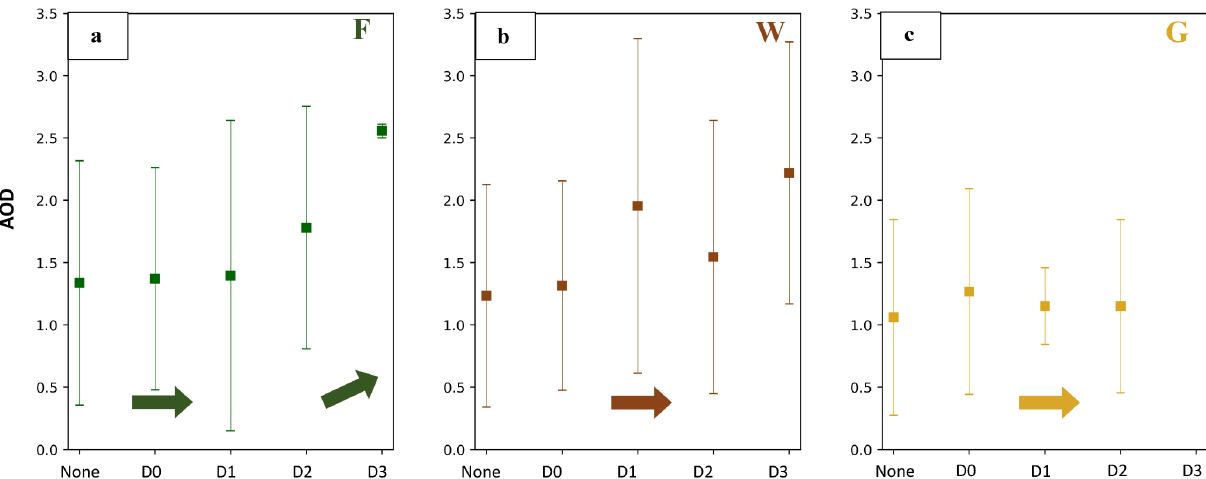
Figure 8. Median plume AOD according to plume type and drought level. Panels are color-coded by plume type and identified with the appropriate abbreviation in the top right-hand corner. Points represent the mean values, and whiskers are the standard deviations. Arrows highlight the general trends with increasing drought: up arrows signify that the trend is statistically significant, and flat arrows indicate that they are not. Note that AOD begins to increase with increasing drought level from D2 onward for Forest plumes; for Woody plumes, the differences in AOD are only significant when comparing the “None” category to the D3 category, with no clear trend in intermediate categories; for Grassy plumes, there are no statistically significant relationships between AOD and drought